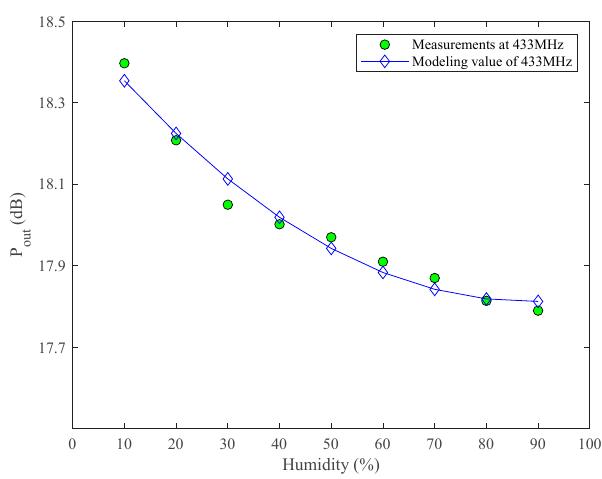
Figure 7. Saturation output power vs. humidity at 433 MHz.